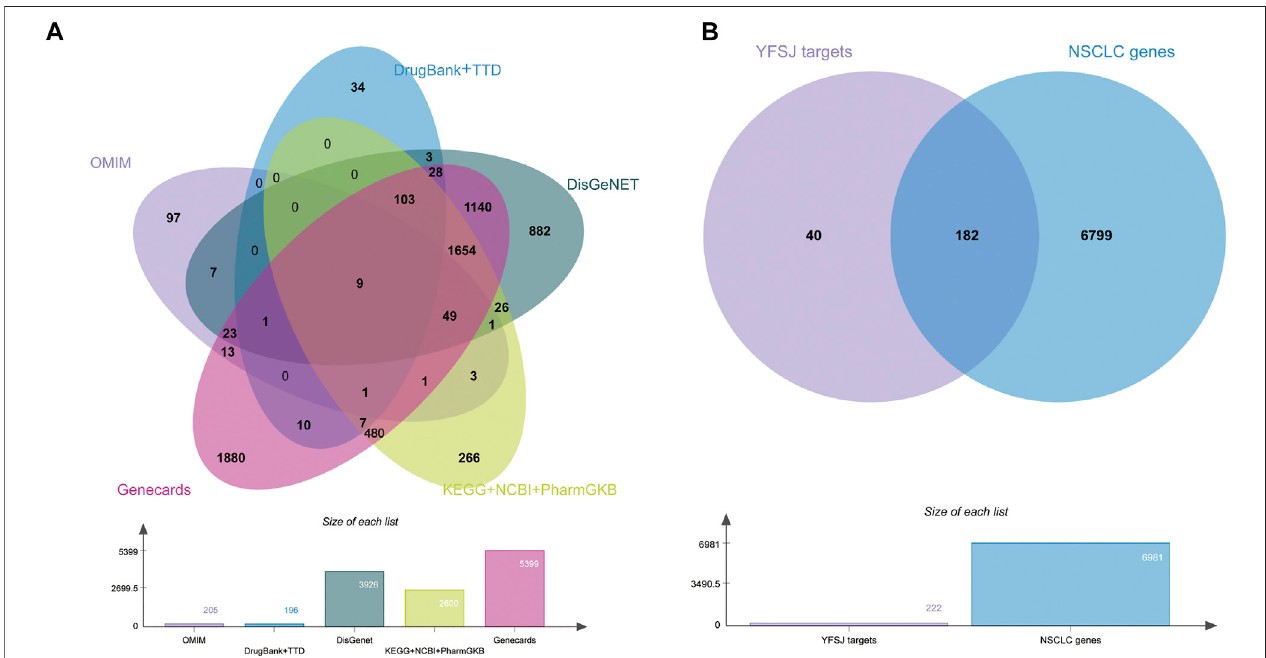
FIGURE 3 | Eight databases were searched for NSCLC-related genes (A) . The intersection of YFSJ targets and NSCLC-related genes (B) .